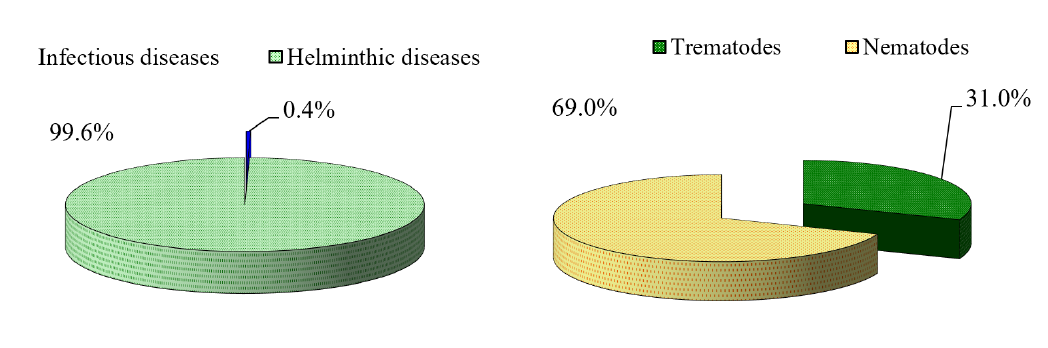
Fig. 4. The ratio of infectious and helminthic diseases (a), cestodes, and nematodes (b) in sheep in the Poltava region